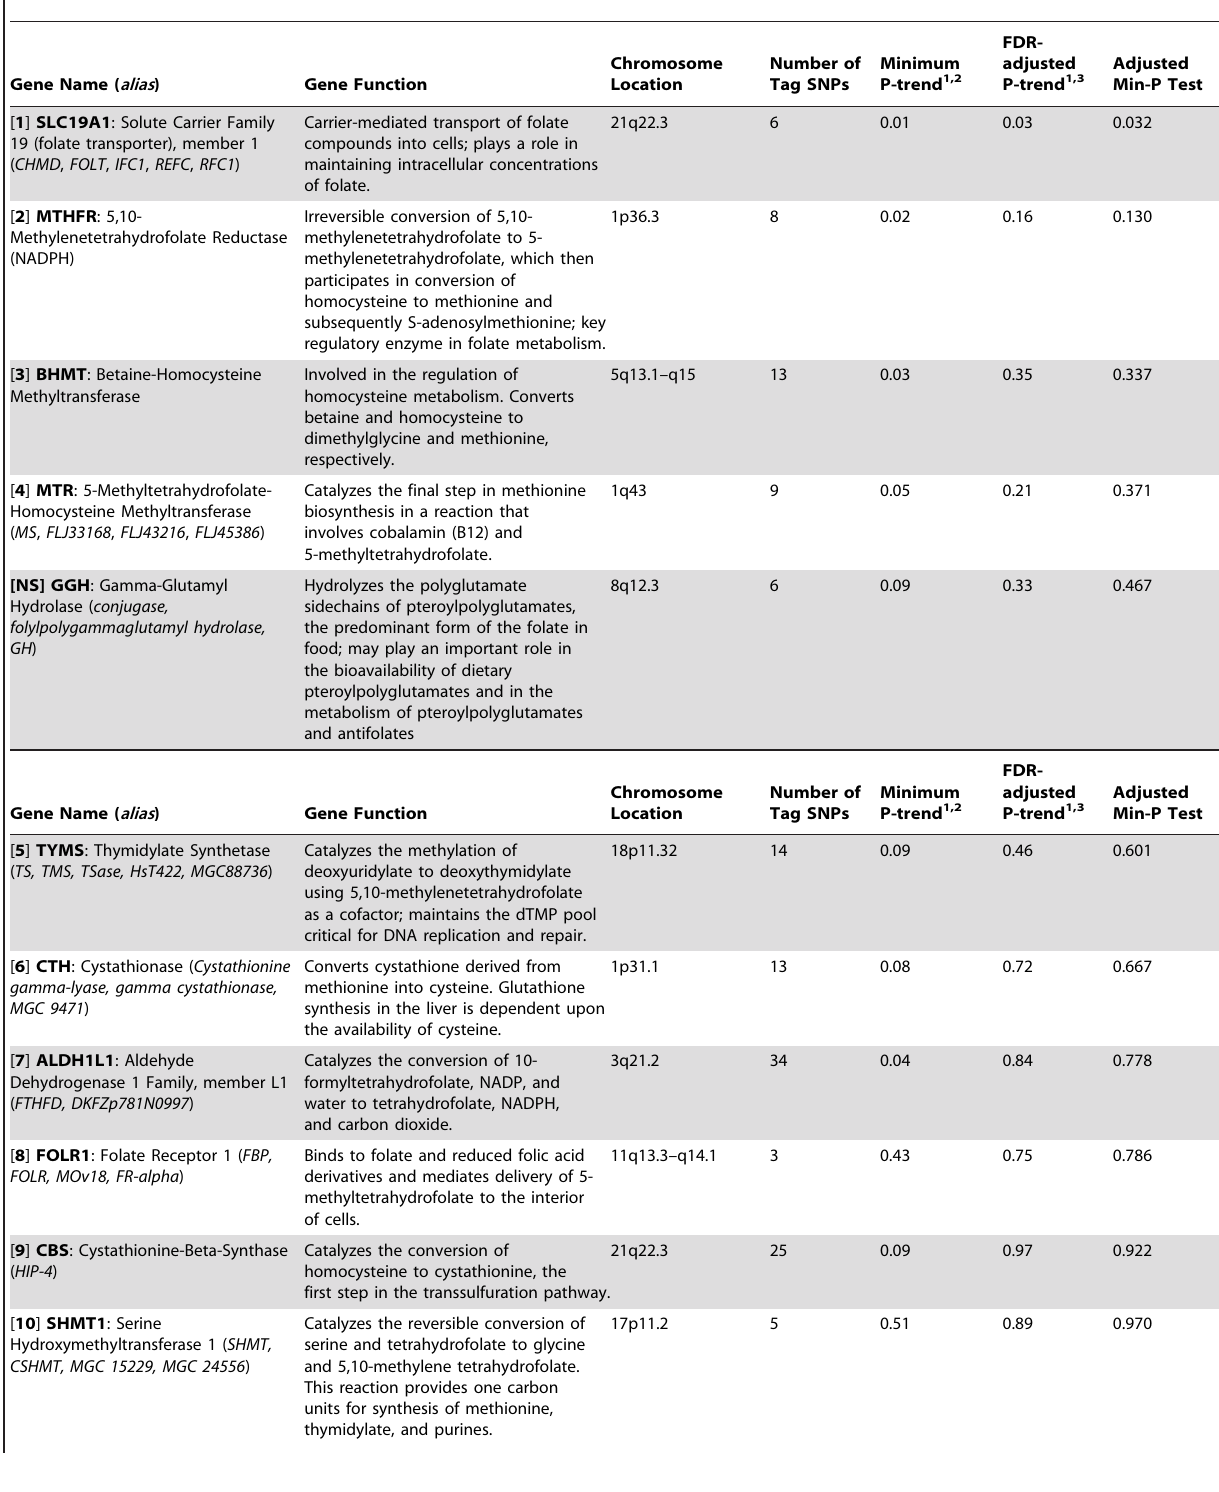
Table 1. Individual SNP and gene-based global minimum p-values for candidate one-carbon metabolism genes and risk of renal cell